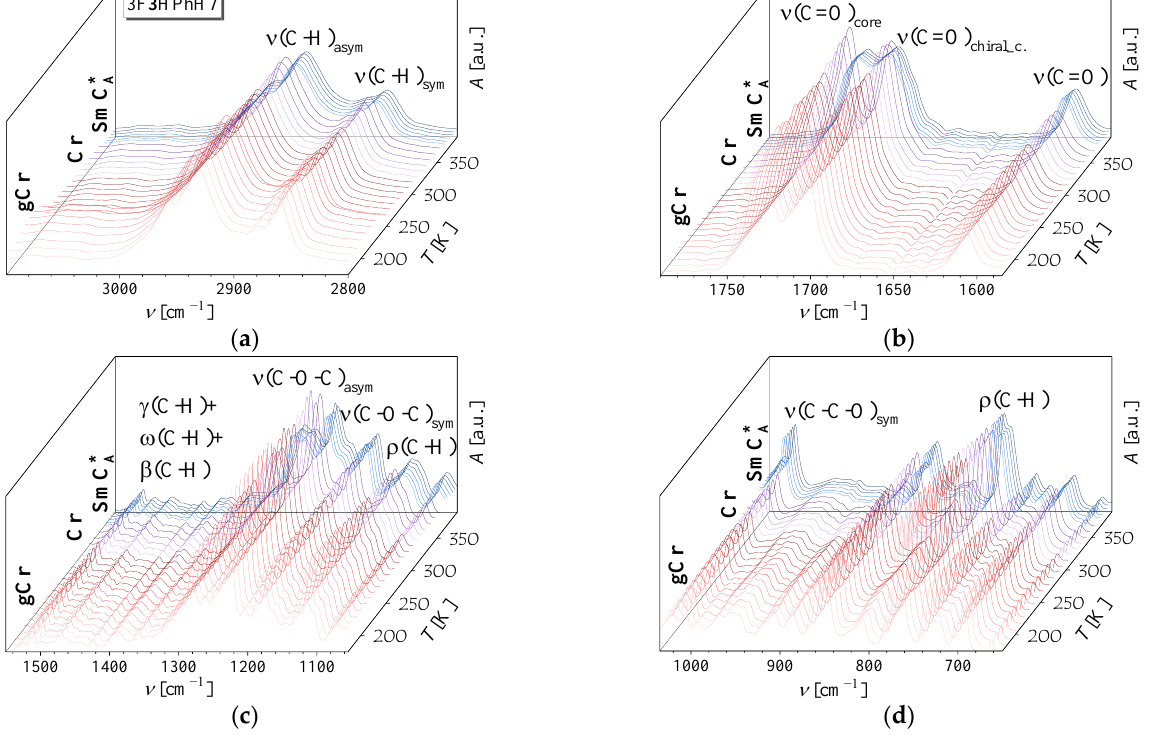
Figure 6. Infrared spectra of the 3F 3 HPhH7 obtained upon heating with the rate of 2 K min −1 (after fast cooling) in the wavenumber regions of 3100 – 2800 cm −1 ( a ), 1800 – 1580 cm −1 ( b ), 1550 – 1050 cm −1 ( c ) and 1040 – 650 cm −1 ( d ). Abbreviations: ν - stretching, γ - bending out-of- plane, ω - wagging, β - bending in- plane, ρ -rocking, asym-asymmetric, sym-symmetric.